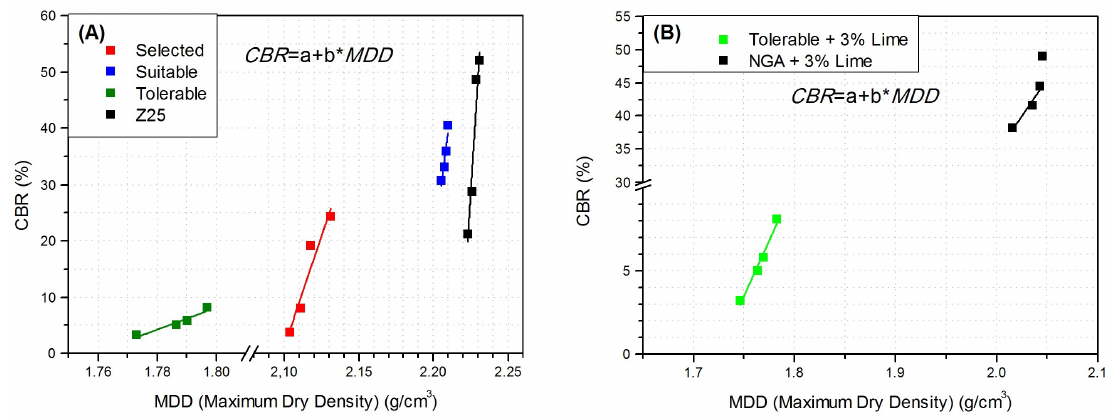
Figure 7. CBR versus density computed relationships for six subbase materials prepared as: ( A ) classified soils, and ( B ) stabilized